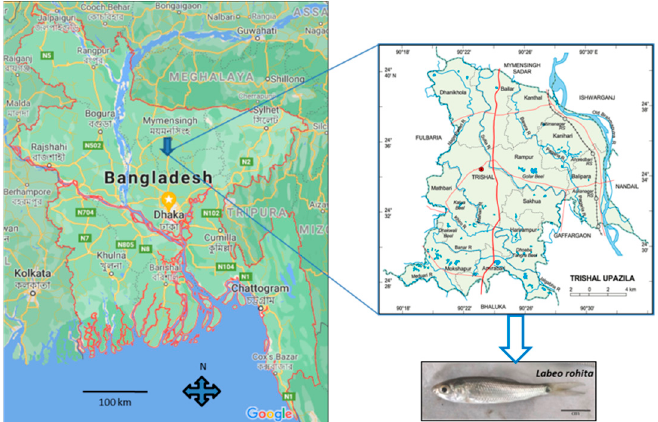
Figure 1. Rohu carp fry collection site in Trishal Upazila of Bangladesh.